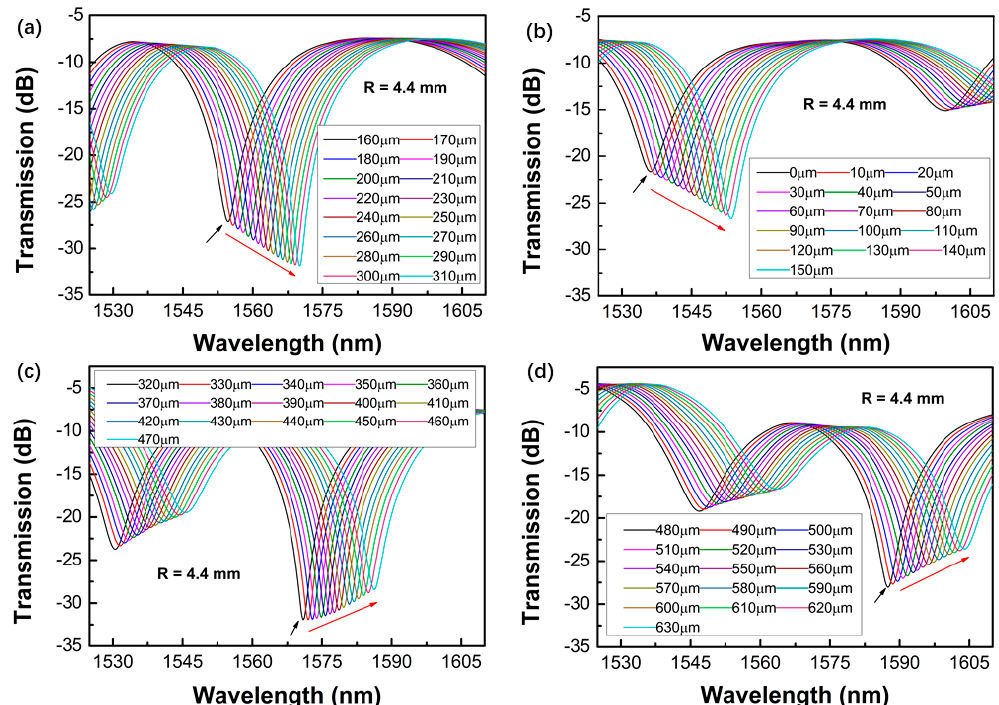
Figure 6. Transmission spectra of the proposed sensors varied with the displacement ranges of 0–150